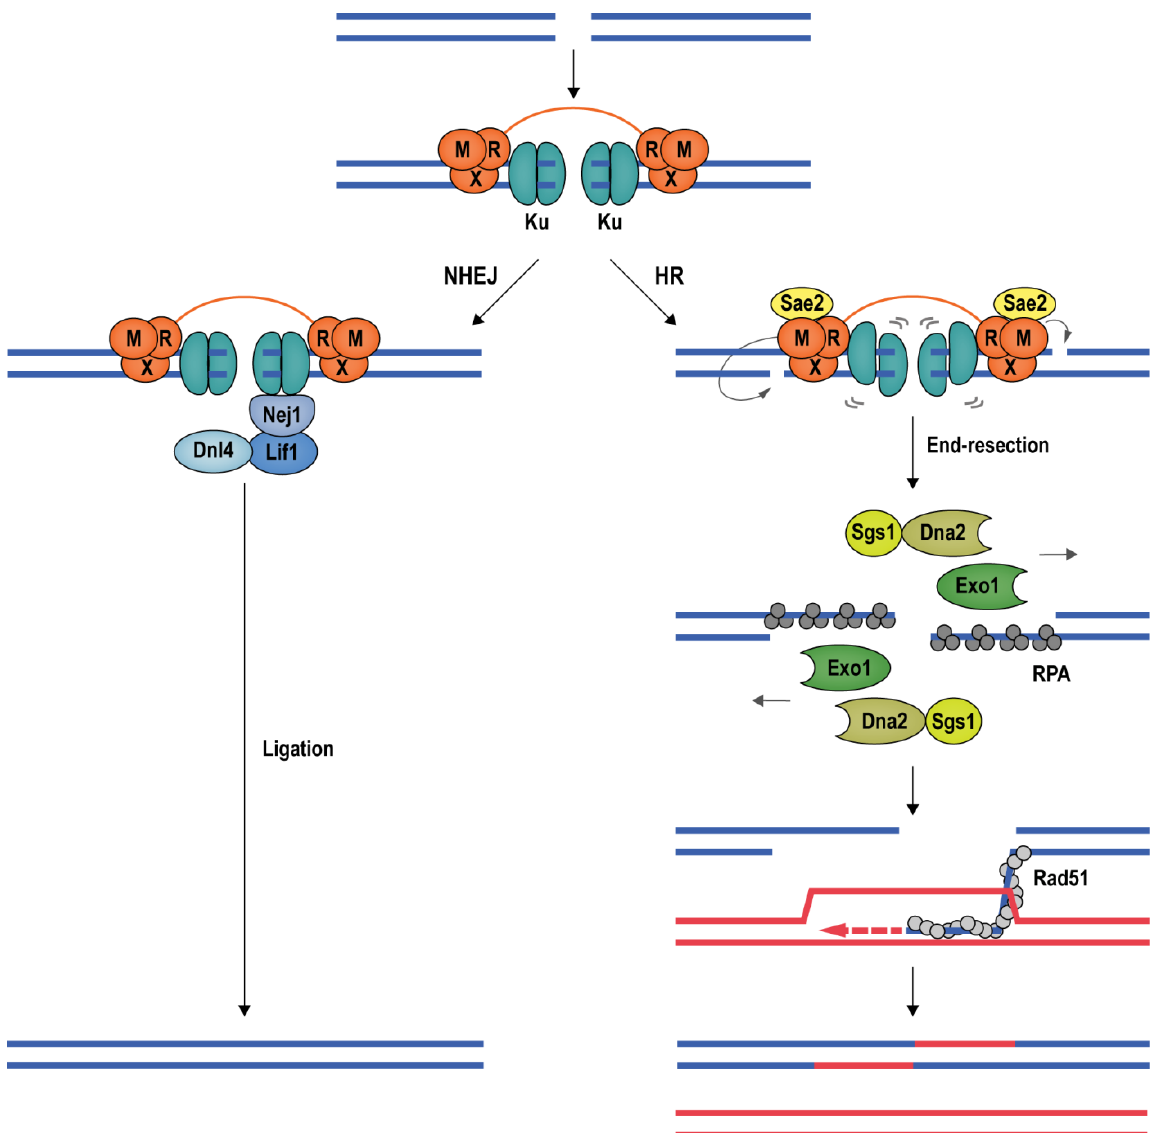
FIGURE 5: DSB repair by NHEJ and HR. The conserved mechanisms of DSB repair by NHEJ and HR are illustrated with budding yeast pro- teins. Left ; Ku encircles DSB ends, recruiting the Lif1-Dnl4 and Nej1 ligase complex to promote NHEJ. Right ; Stimulated by phosphorylated Sae2, Mre11 introduces nicks in the 5ʹ-terminated DNA strands, destabilizing Ku. At the nicks, Exo1 and Sgs1-Dna2 initiate long-range end- resection, exposing ssDNA, which is first coated by RPA, then by recombinase Rad51. The Rad51 nucleoprotein filament seeks out and in- vades a homologous donor sequence to initiate DNA repair synthesis. HR leads mostly to non-crossover products with a repair patch where new DNA has been